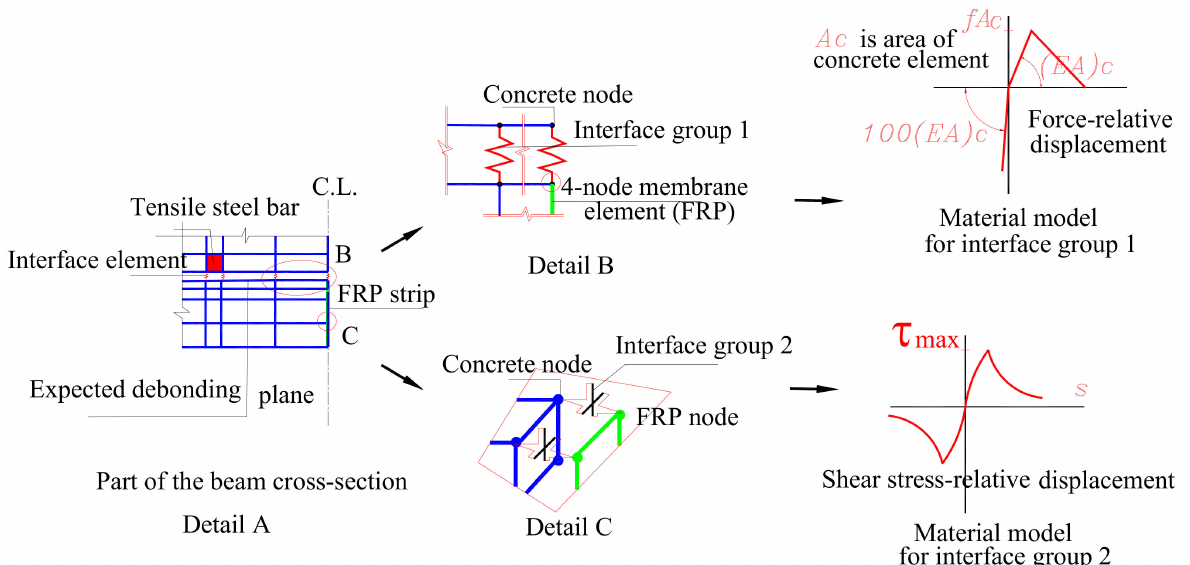
Figure 8. Typical finite element model for NSM